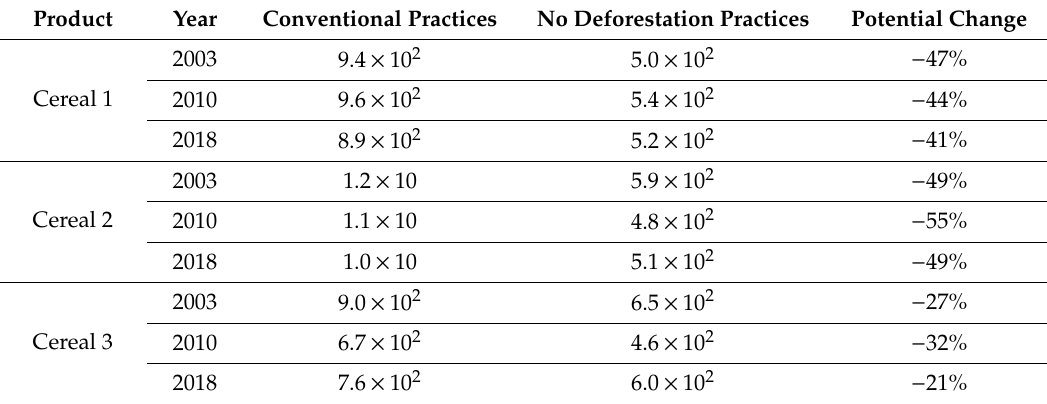
Table 2. E ff ect of introduction of no deforestation practices over climate change impact results (kg CO 2 -eq / 30 g serving